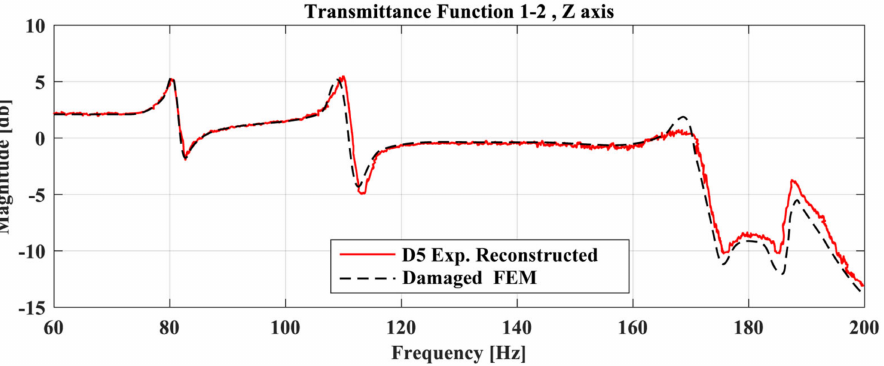
Figure 18. Transmittance Functions of the Damaged FE model and D5 case between accelerometer 1 and 3 at